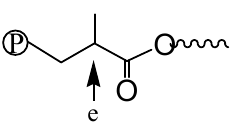
Scheme 3. Chain microstructure resulting from the five-membered chelate